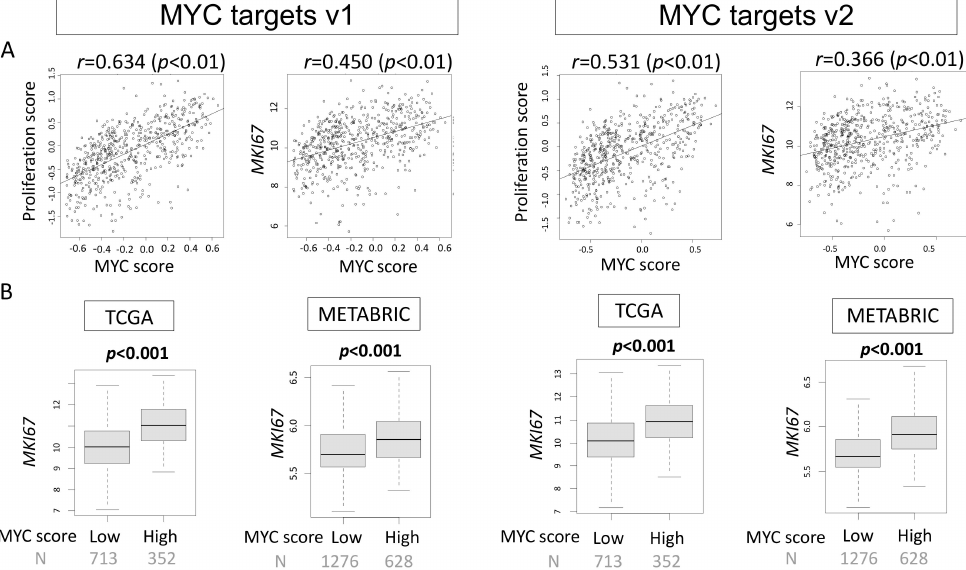
Figure 1. Association of the MYC targets v1 and MYC targets v2 scores with the proliferation score and expression of the MKI67 gene (encodes KI67, the most commonly used marker for cell proliferation) in the TCGA and METABRIC cohorts. ( A ) MYC targets v1 and MYC targets v2 correlate with the proliferation score and expression of MKI67 in the TCGA cohort. ( B ) High MYC targets v1 and MYC targets v2 score groups are significantly associated with increased expression of MKI67 in both TCGA and METABRIC cohorts. Spearman rank correlation and one-way ANOVA were used for the analysis. 2.2. MYC Targets v1 and MYC Targets v2 Scores Are Elevated in Clinically Aggressive Breast